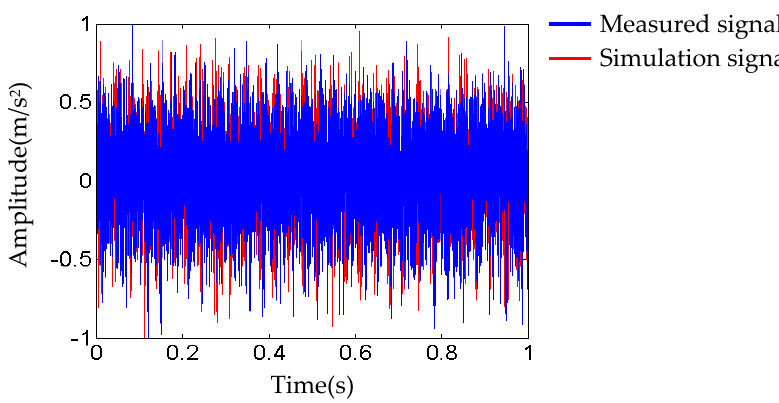
Figure 4. The comparison between measured and simulated signals in normal state.